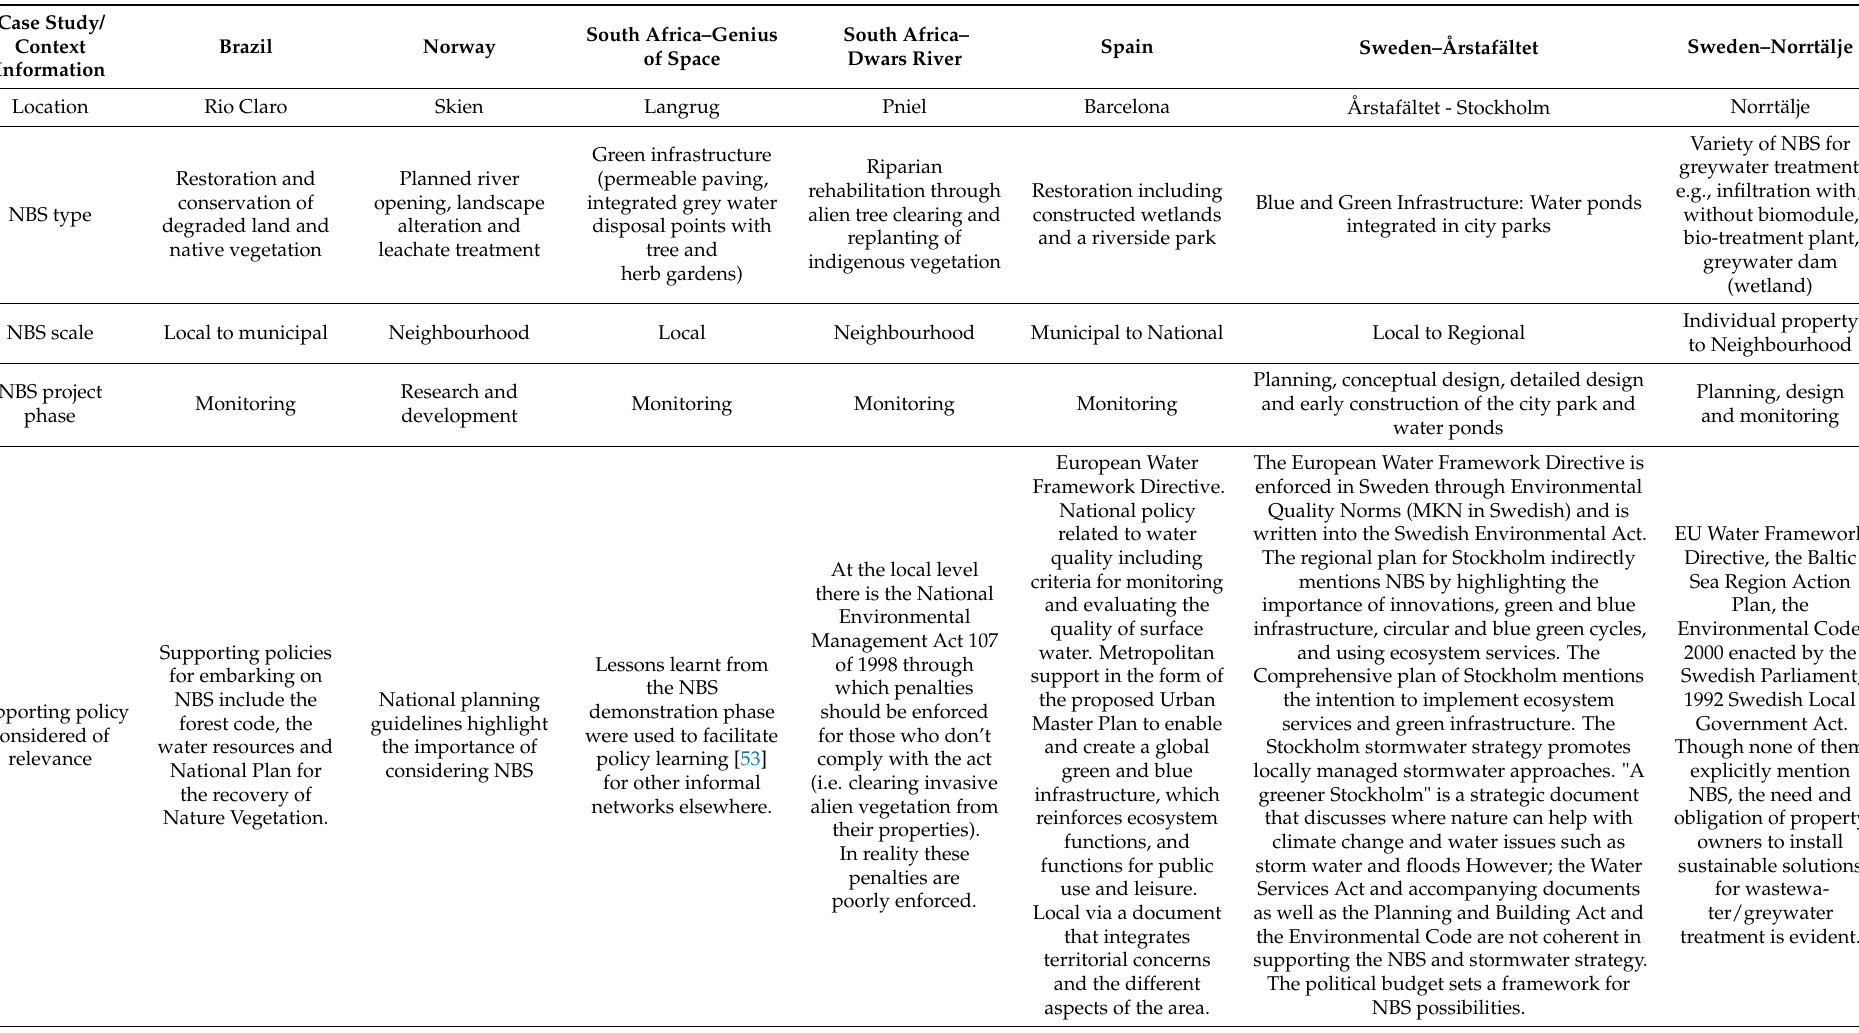
Table 3. Summary of the main information collected in the context stage of the